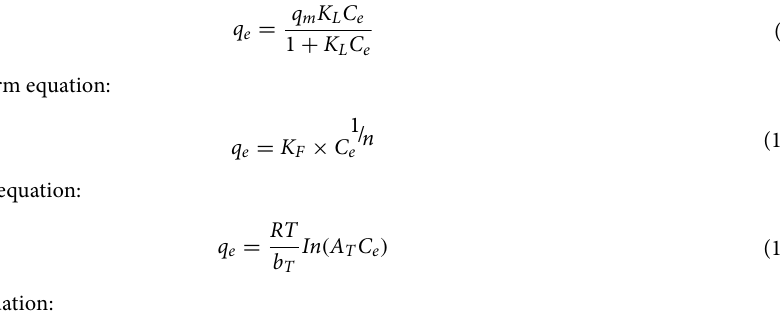
and pseudo-second-order model, respectively; k (mg/(g min)) is the adsorption rate constant, f 2 (dimension- less) and K ip (mg/(g min 0.5 )) are the coefficient of mixed 1,2 order and intraparticle diffusion, respectively; c ip (mg/g) is the intraparticle diffusion constant; k av (1/min) is the Avrami rate constant; n av (dimensionless) is the Avrami component. Table 1 listed the fitting parameters calculated from these kinetic models (Fig. 6). The pseudo-first order, pseudo-second order, mixed 1, 2-order and Avrami models with a high correlation coefficient (R 2 > 0.98) described the adsorption process of U(VI) better than the intrsparticle difusion kinetic model (R 2 = 0.44). Effect of initial U(VI) concentration and isotherm studies. The adsorption behavior of U(VI) on Fe 3 O 4 @SiO 2 @UiO-66-TPP NPs was investigated by changing the initial U(VI) concentration from 1.6 to 280 mg/L. As shown in Fig. 7a, the adsorption amounts increased quickly with the enhancement of the initial U(VI) concentration from 1.6 to 78.5 mg/L. Then the adsorption reached the maximum capacity when the initial U(VI) concentration was above 200 mg/L, which is ascribed to the saturation of phosphate group binding sites